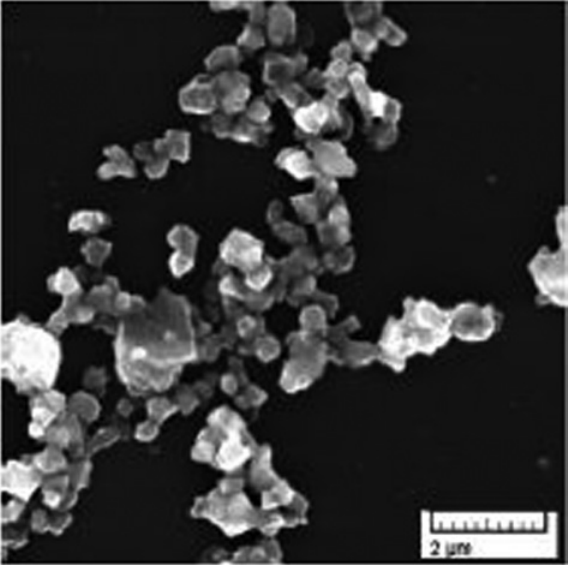
Figure 8: Sem Microstructures of Titanium Carbide Synthesized at 1300 ° C for 1